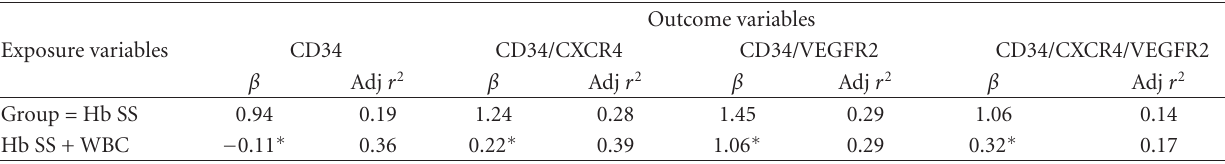
Table 4: Bivariate linear regression showing relationship between Hemoglobin SS group, WBC, and CPC types. WBC was found to be a strongly associated with CPC number in the Hemoglobin SS group. Significant reductions in the beta-coe ffi cient ( > 25%) compared to the main exposure variable are marked with an asterisk ( ∗